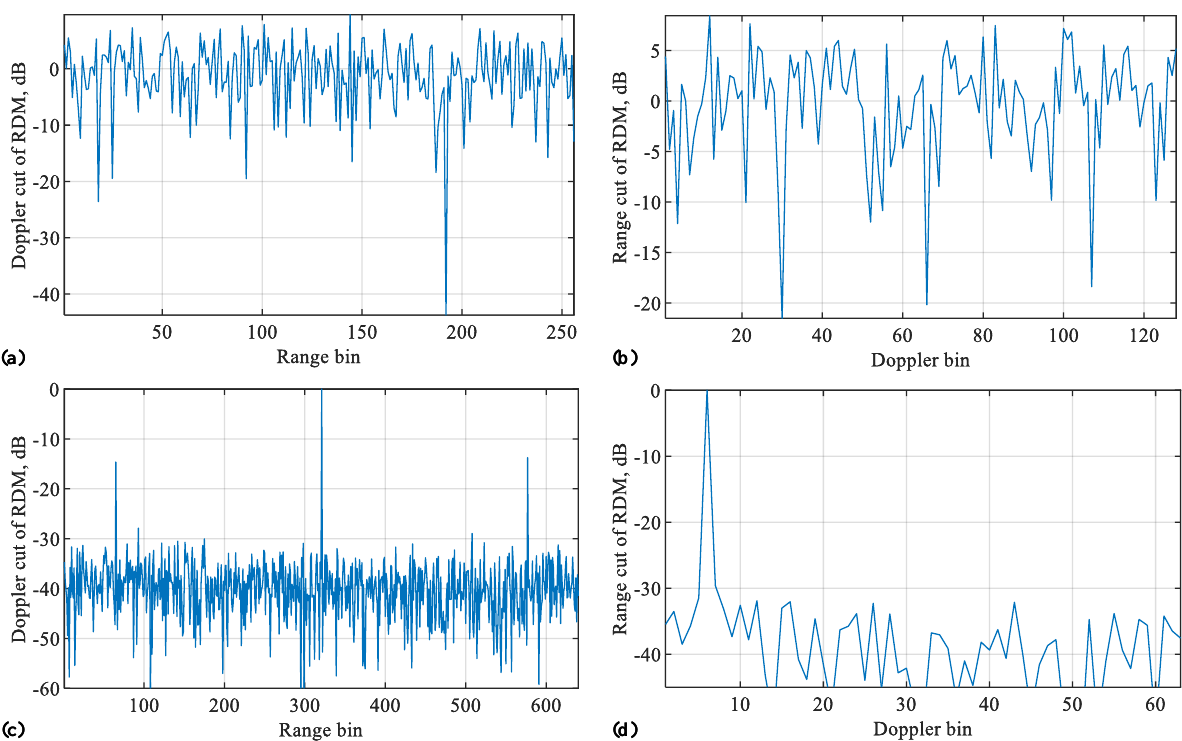
Figure 2. Doppler ( a ) and range ( b ) cuts of the RDM obtained by COS, as plotted in Figure 1b. Doppler ( c ) and range ( d ) cuts of the RDM obtained by USF, as plotted in Figure 1a. Please note that the symbol “-” before all numbers, as automatically generated by MATLAB during plotting the figure, denotes the negative